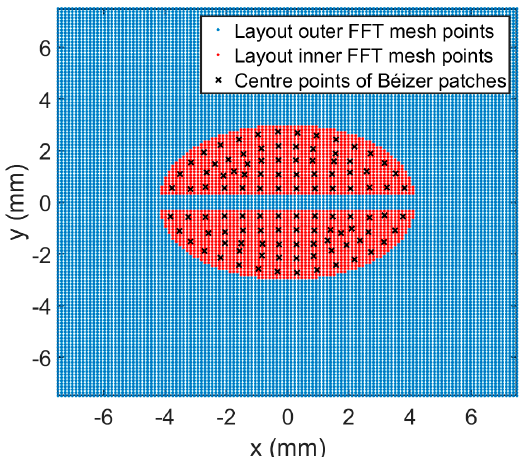
Figure 4. Equi-spaced mesh points x = x m , y = y n , z = -h q 0 < m < N x , 0 < n < N y that are inside of the unit cell 15 × 15 mm 2 . The values of N x = N y = 127 and L 1 = 4.1365 mm are considered. The centre points of the Bézier patches used in the definition of the BFs are also shown.